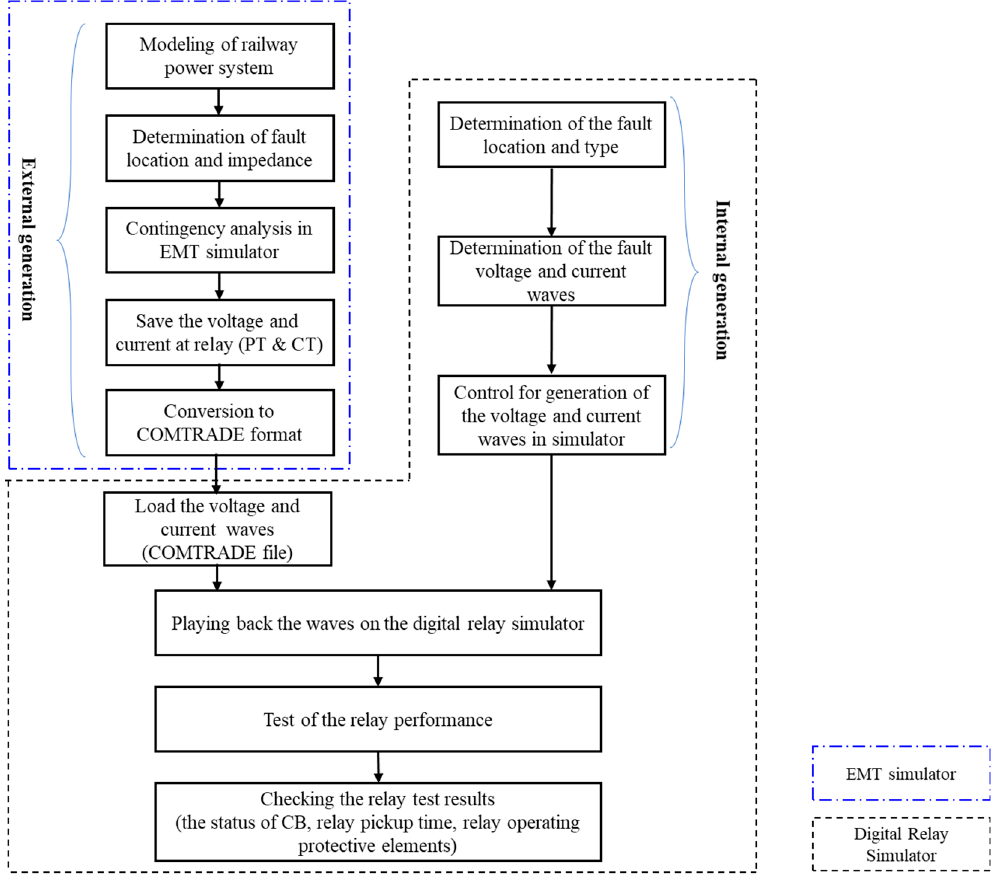
Figure 1. Protective relay digital simulator for railway (PREDIS-R) performance scheme.